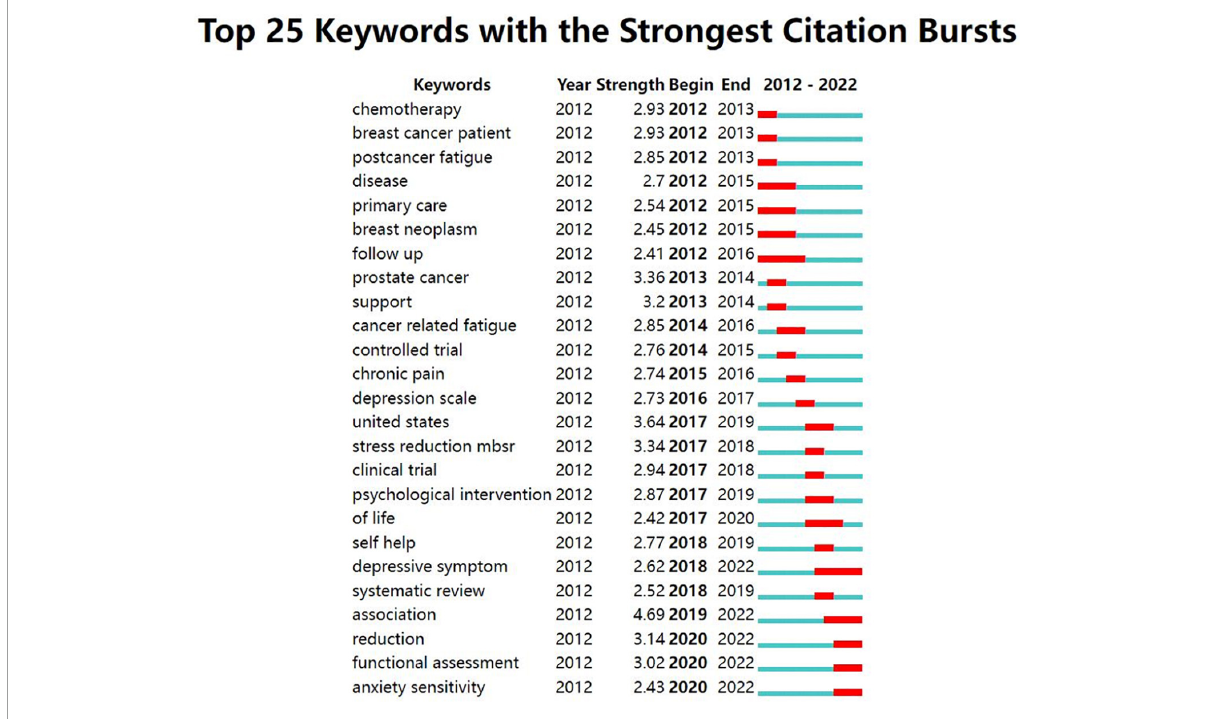
FIGURE13 Top 25 keywords with highest citations bursts in this